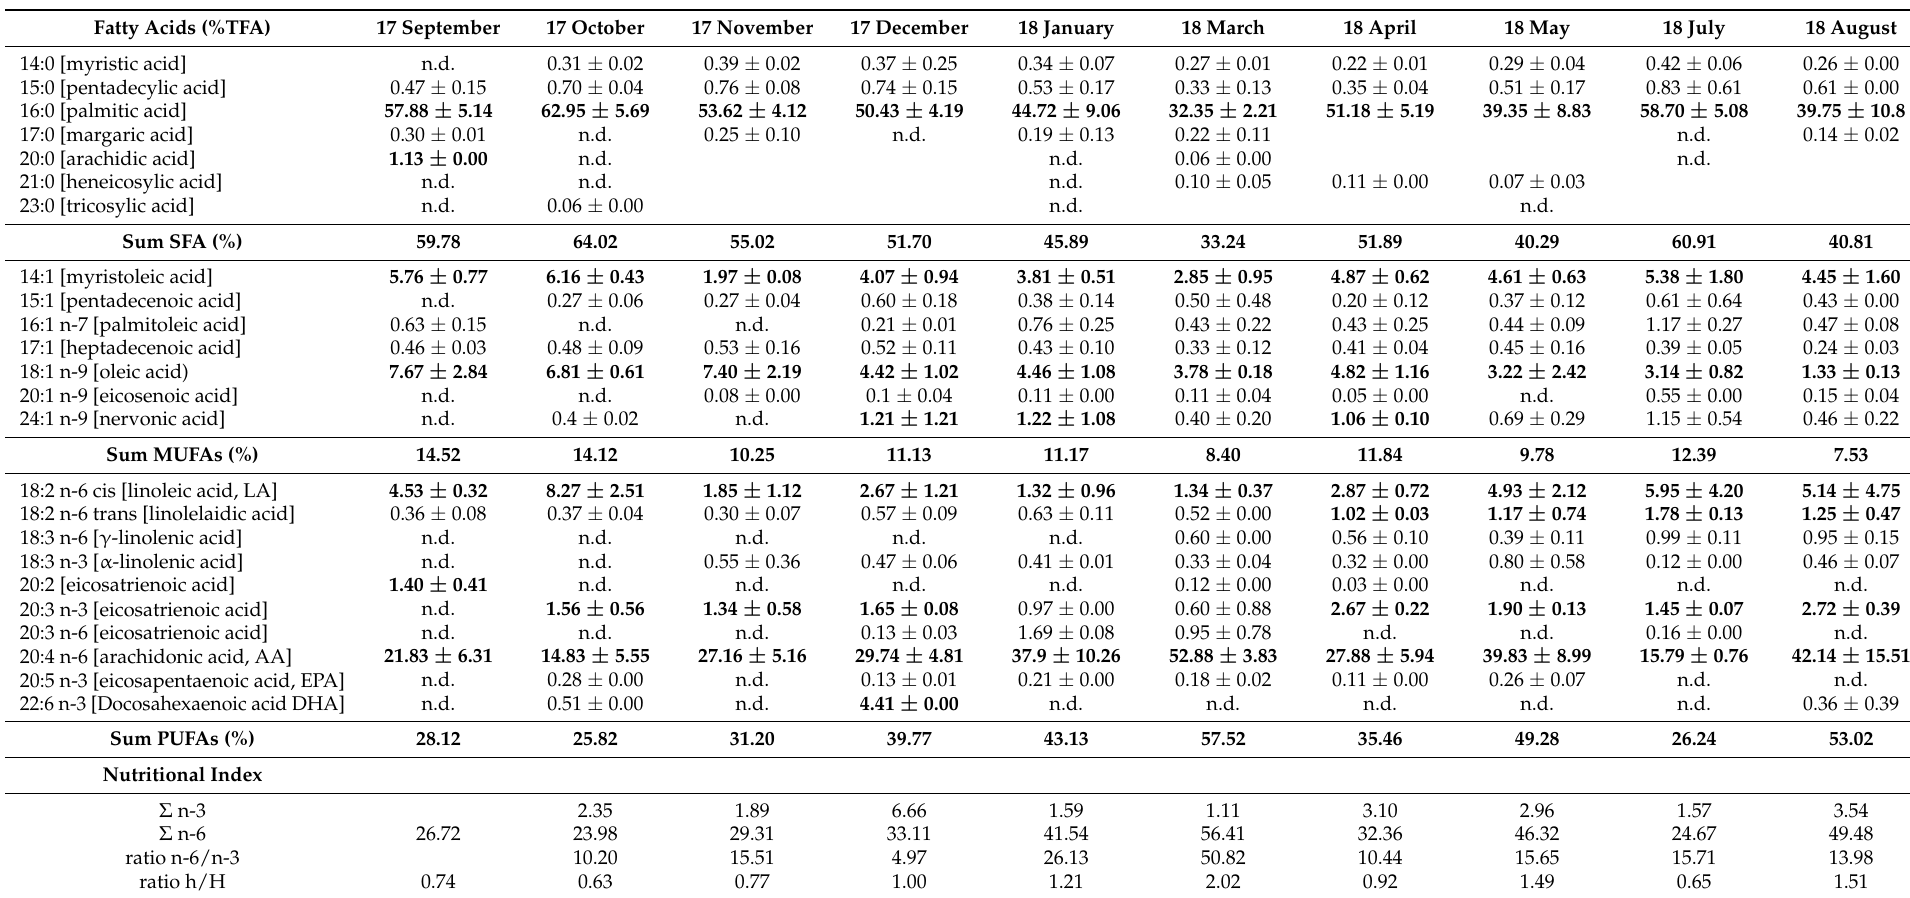
Table 2. Fatty acid composition in A. vermiculophyllum (as a percentage of total fatty acids, TFA). Data shown is the mean ± SD ( n = 3); h–hypocholesterolemic (MUFAs + PUFAs); H—hypercholesterolemic (C14:0 + C16:0). Bold values represent fatty acids with at least 1% of the total fatty acid composition. n.d. = not detected. Fatty Acids